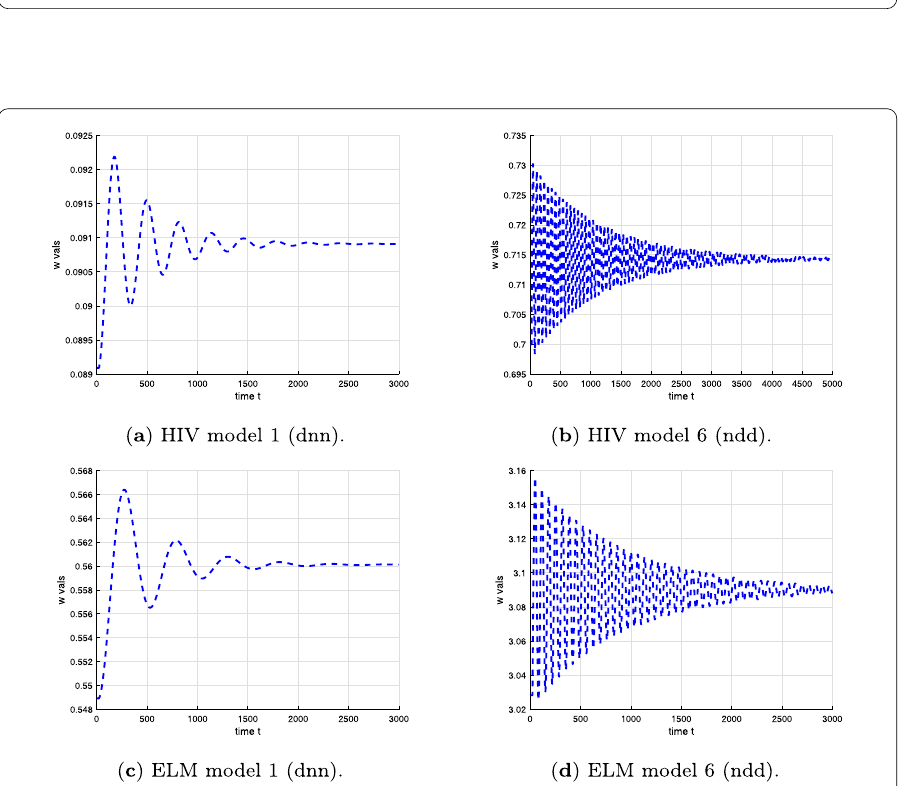
Figure 4 Solutions of HIV and ELM difference equations versions 1 and 6 for time delay less than critical delay at m = 22 and τ < τ c (see Tables 11 and